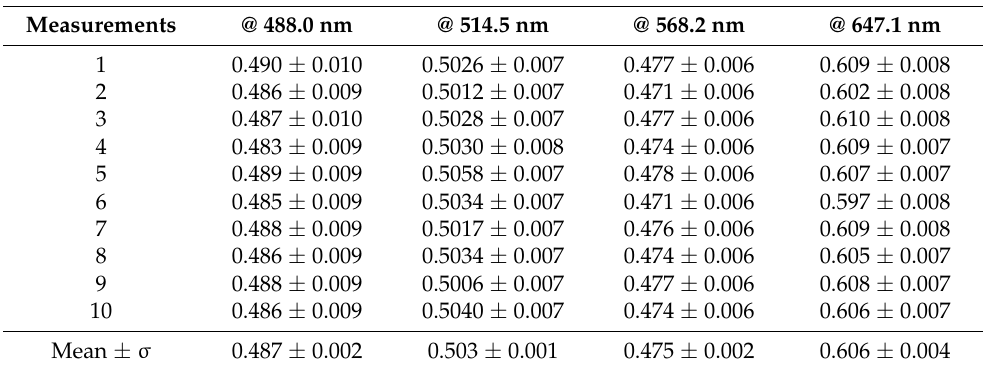
Table 3. Repeated measurements of the anti-Stokes/Stokes ratio at room temperature collected at 488.0, 514.5, 568.2 and 647.1 nm using a laser power of 1–2 mW depending on the excitation wavelength used. In the final row, mean values of the anti-Stokes/Stokes ratios and the standard deviations are